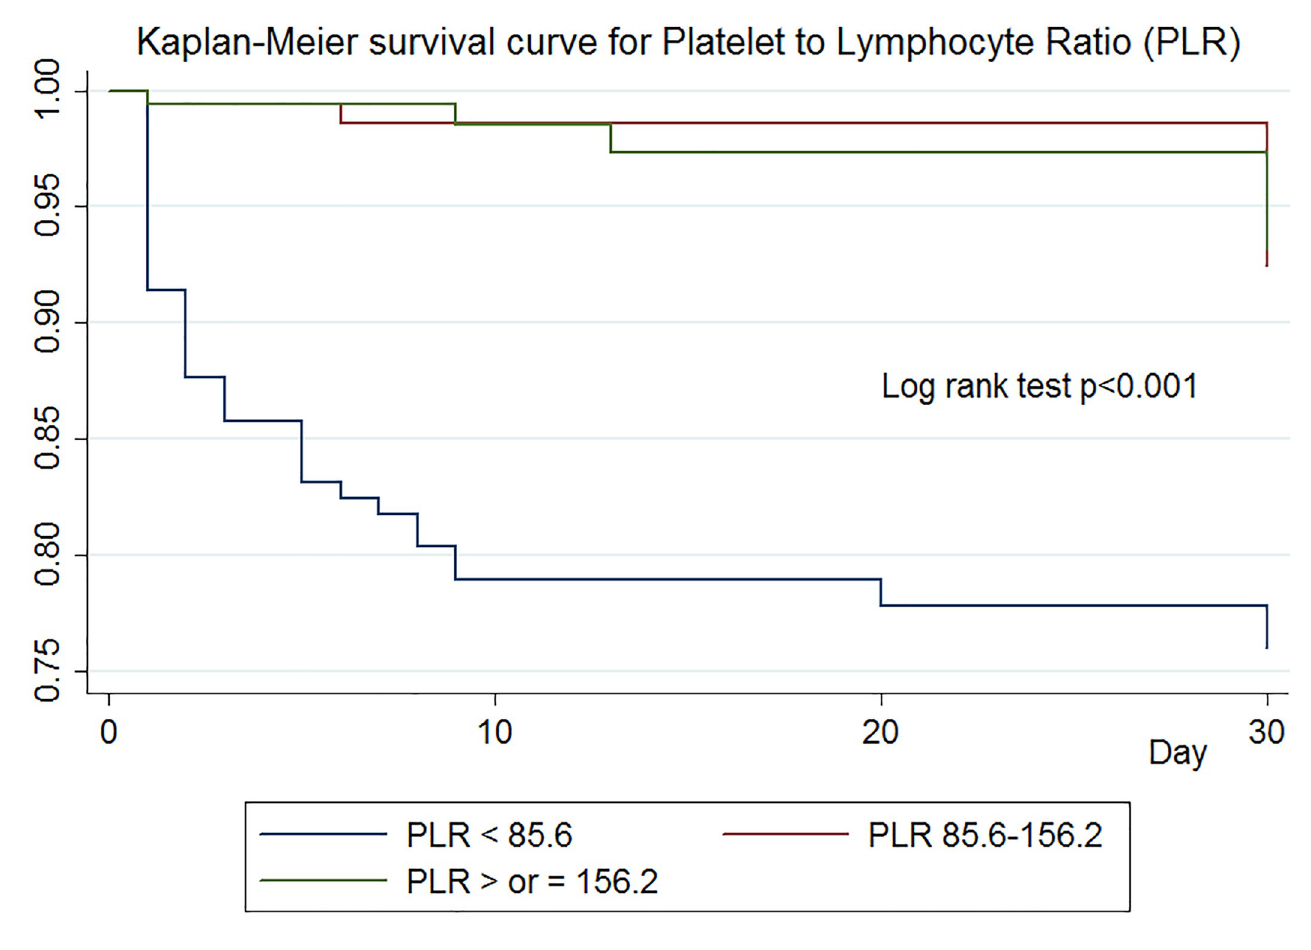
Fig 3. Kaplan-Meier survival curves according to tertiles of platelet-to-lymphocyte ratio (PLR).